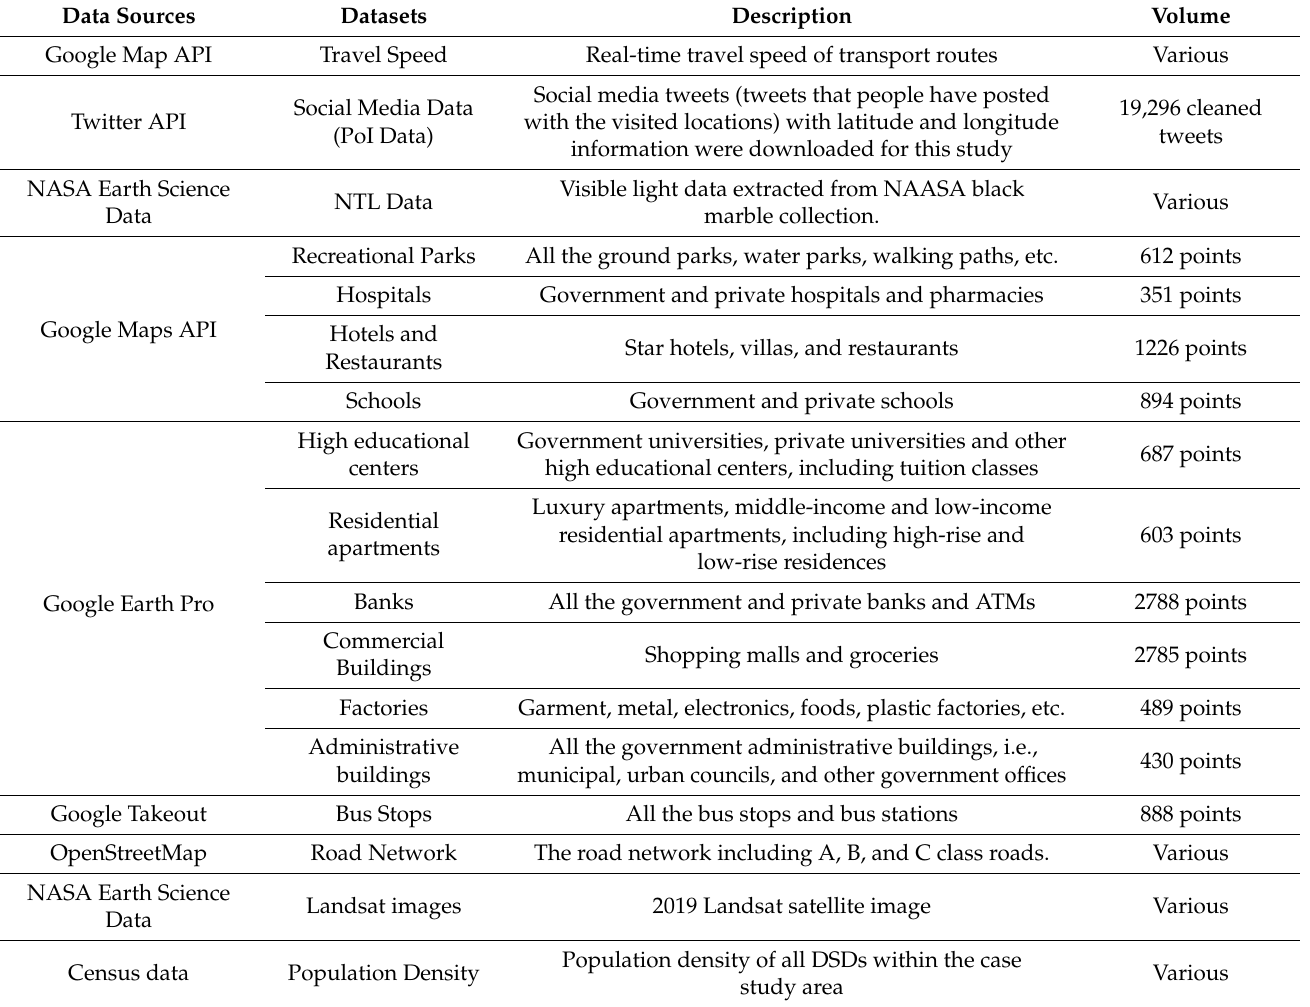
Table 2. Datasets and